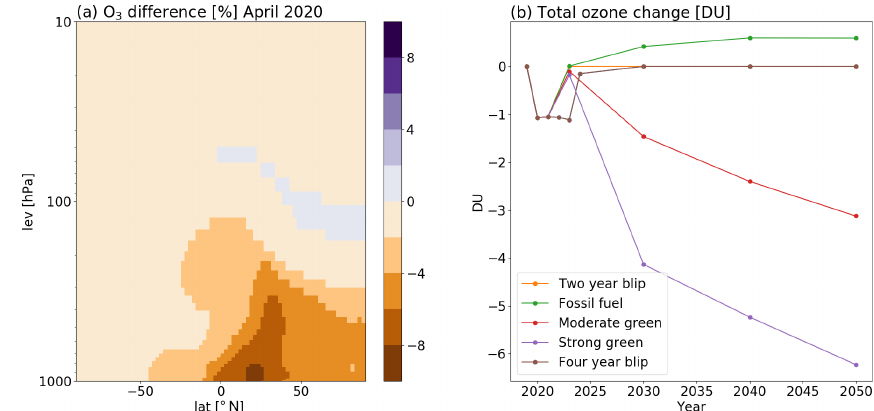
Figure 5. (a) The relative difference in ozone zonal concentration between the 2-year blip and the baseline in April 2020 (%) in the OsloCTM3. The vertical coordinates in OsloCTM3 are hybrid sigma–pressure levels. The field is plotted for the model levels and indi- cated by approximate pressure levels on the y axis. (b) The difference in annual total ozone (DU) between the scenarios and the baseline simulations in the OsloCTM3. Table 3. Table of experiments for CovidMIP. All experiments branch from SSP2-4.5 on 1 January 2020. Emissions/concentrations not specified come from the baseline